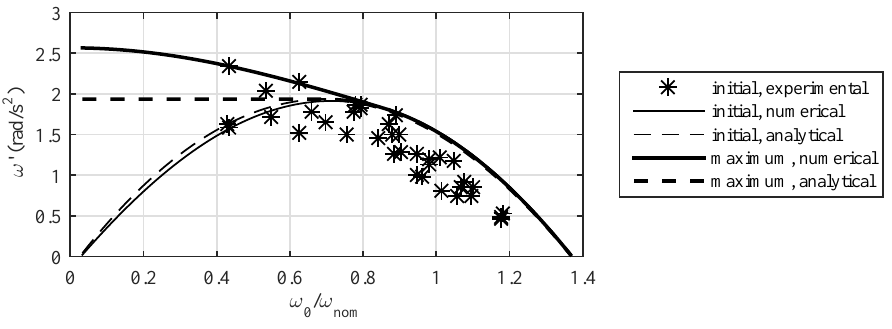
Figure 6. Initial and maximum accelerations predicted analytically and numerically.